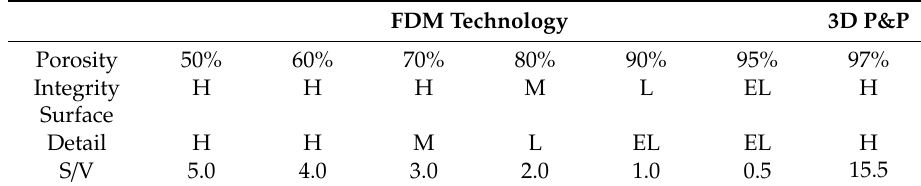
Table 3. Comparison between FDM Technology and 3D P&P Technology.